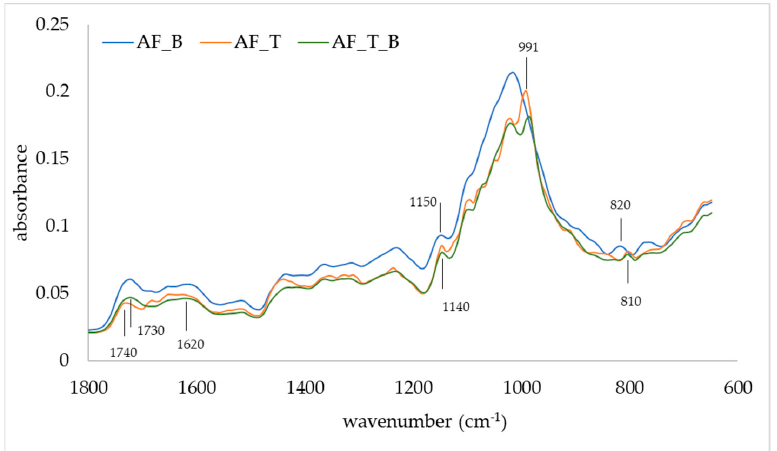
Figure 4. IR spectra of apple fiber/blackberry (AF_B), apple fiber/trehalose (AF_T), and apple fiber/trehalose/blackberry (AF_T_B) microparticles.